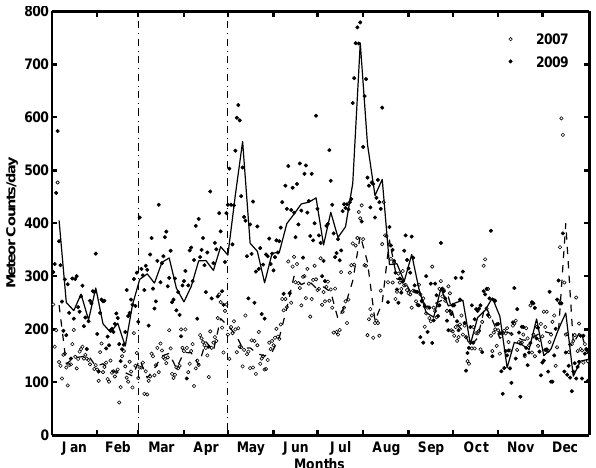
Figure 8. Radio observations of daily meteor counts (circles) along with 5-day average of the counts (curves) at Mie (35.0 ◦ N, 136.6 ◦ E, dip latitude 29.8 ◦ N), Japan for 2007 and 2009. Vertical lines show the beginning and end of the vernal equinoctial